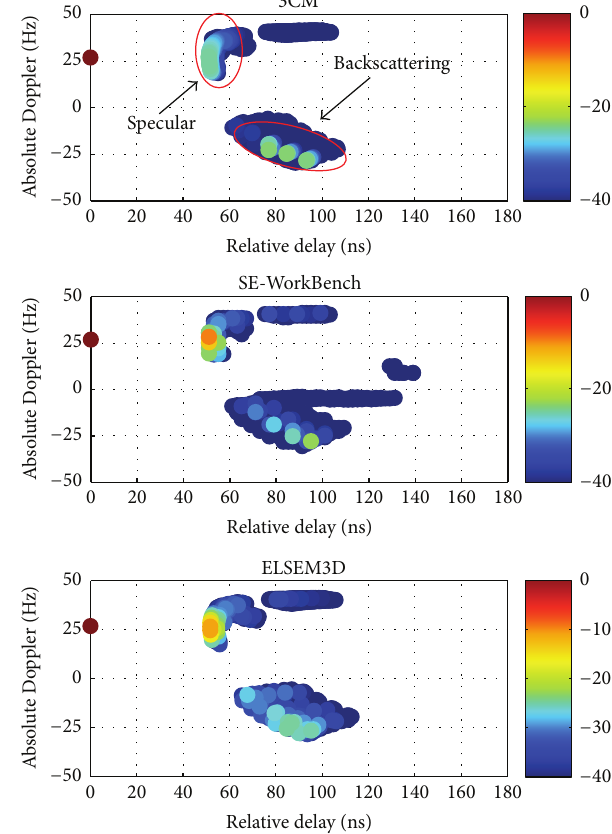
Figure 13: Power delay/Doppler channel